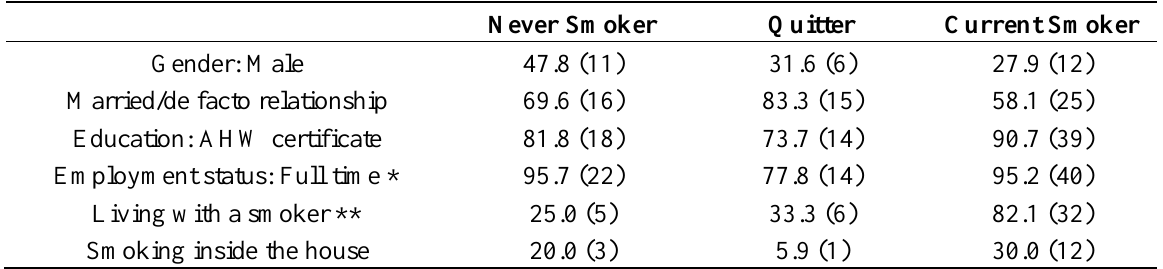
Table 2. Socio-demographic and household smoking variables according to smoking status (% ( n )).